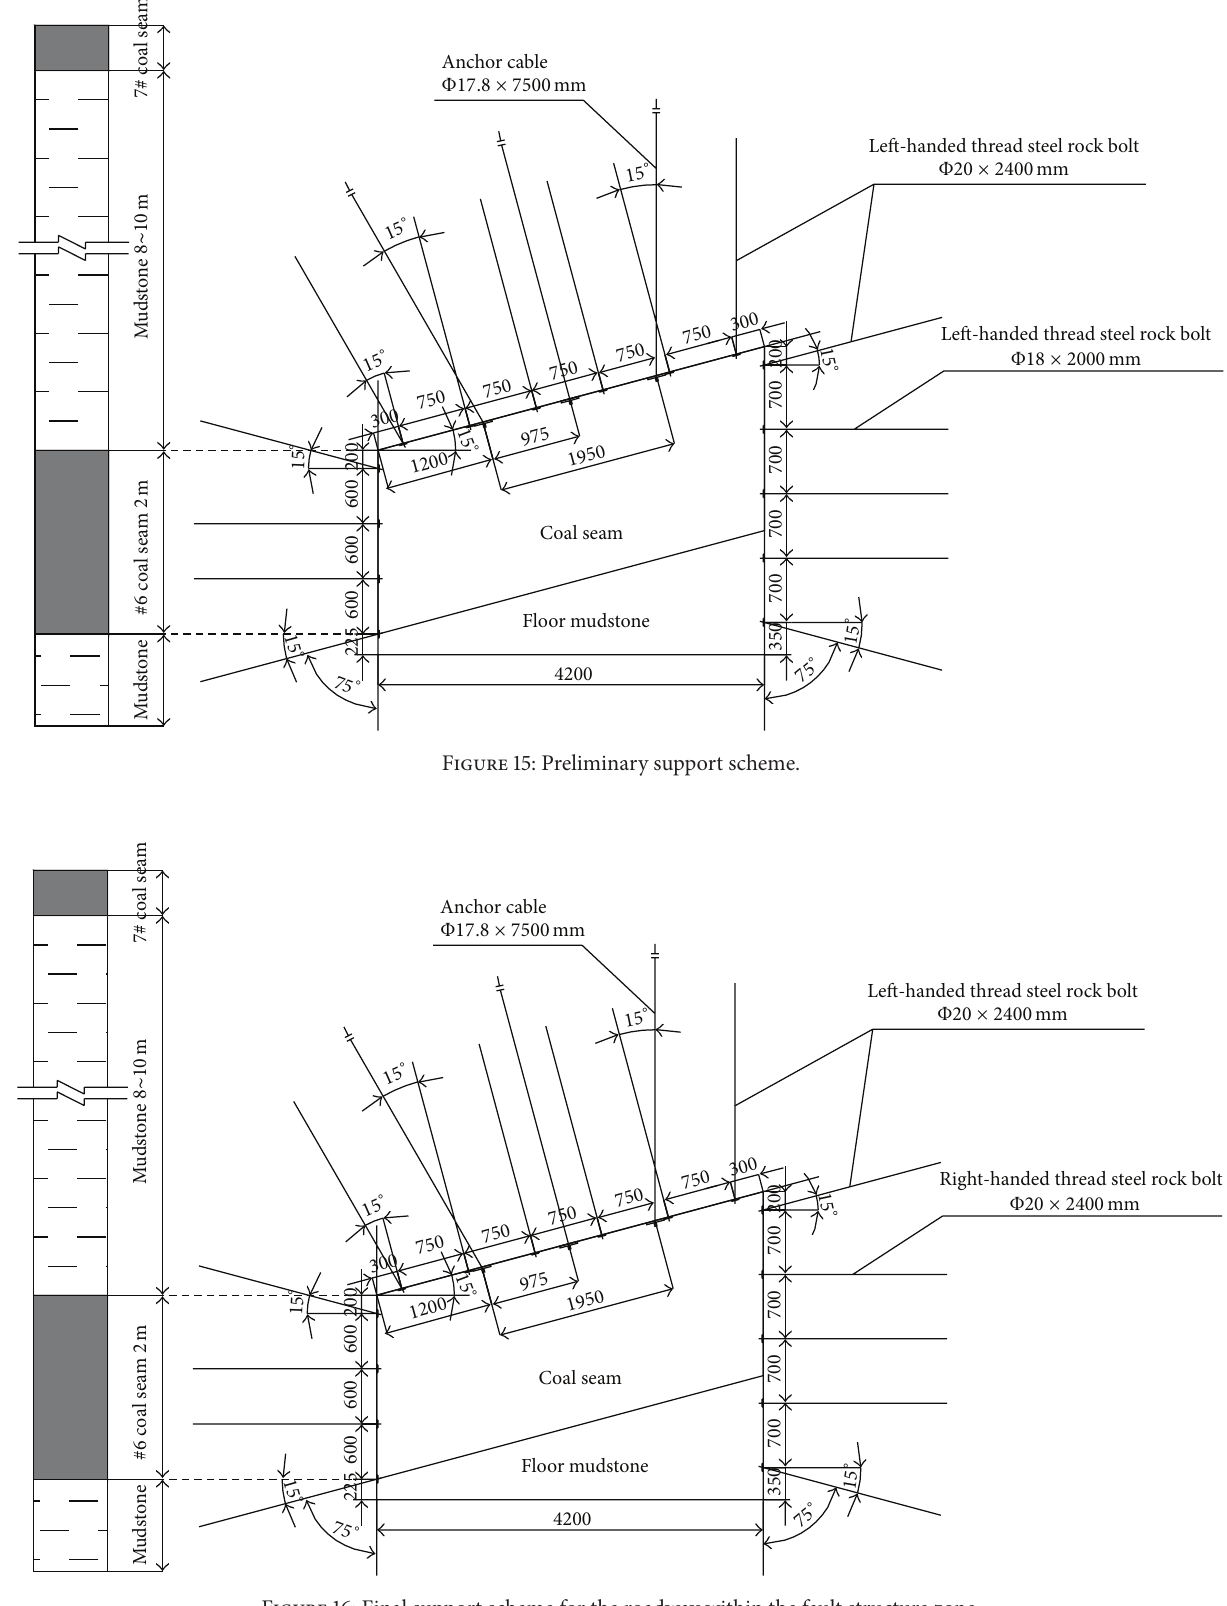
Figure 16: Final support scheme for the roadway within the fault structure